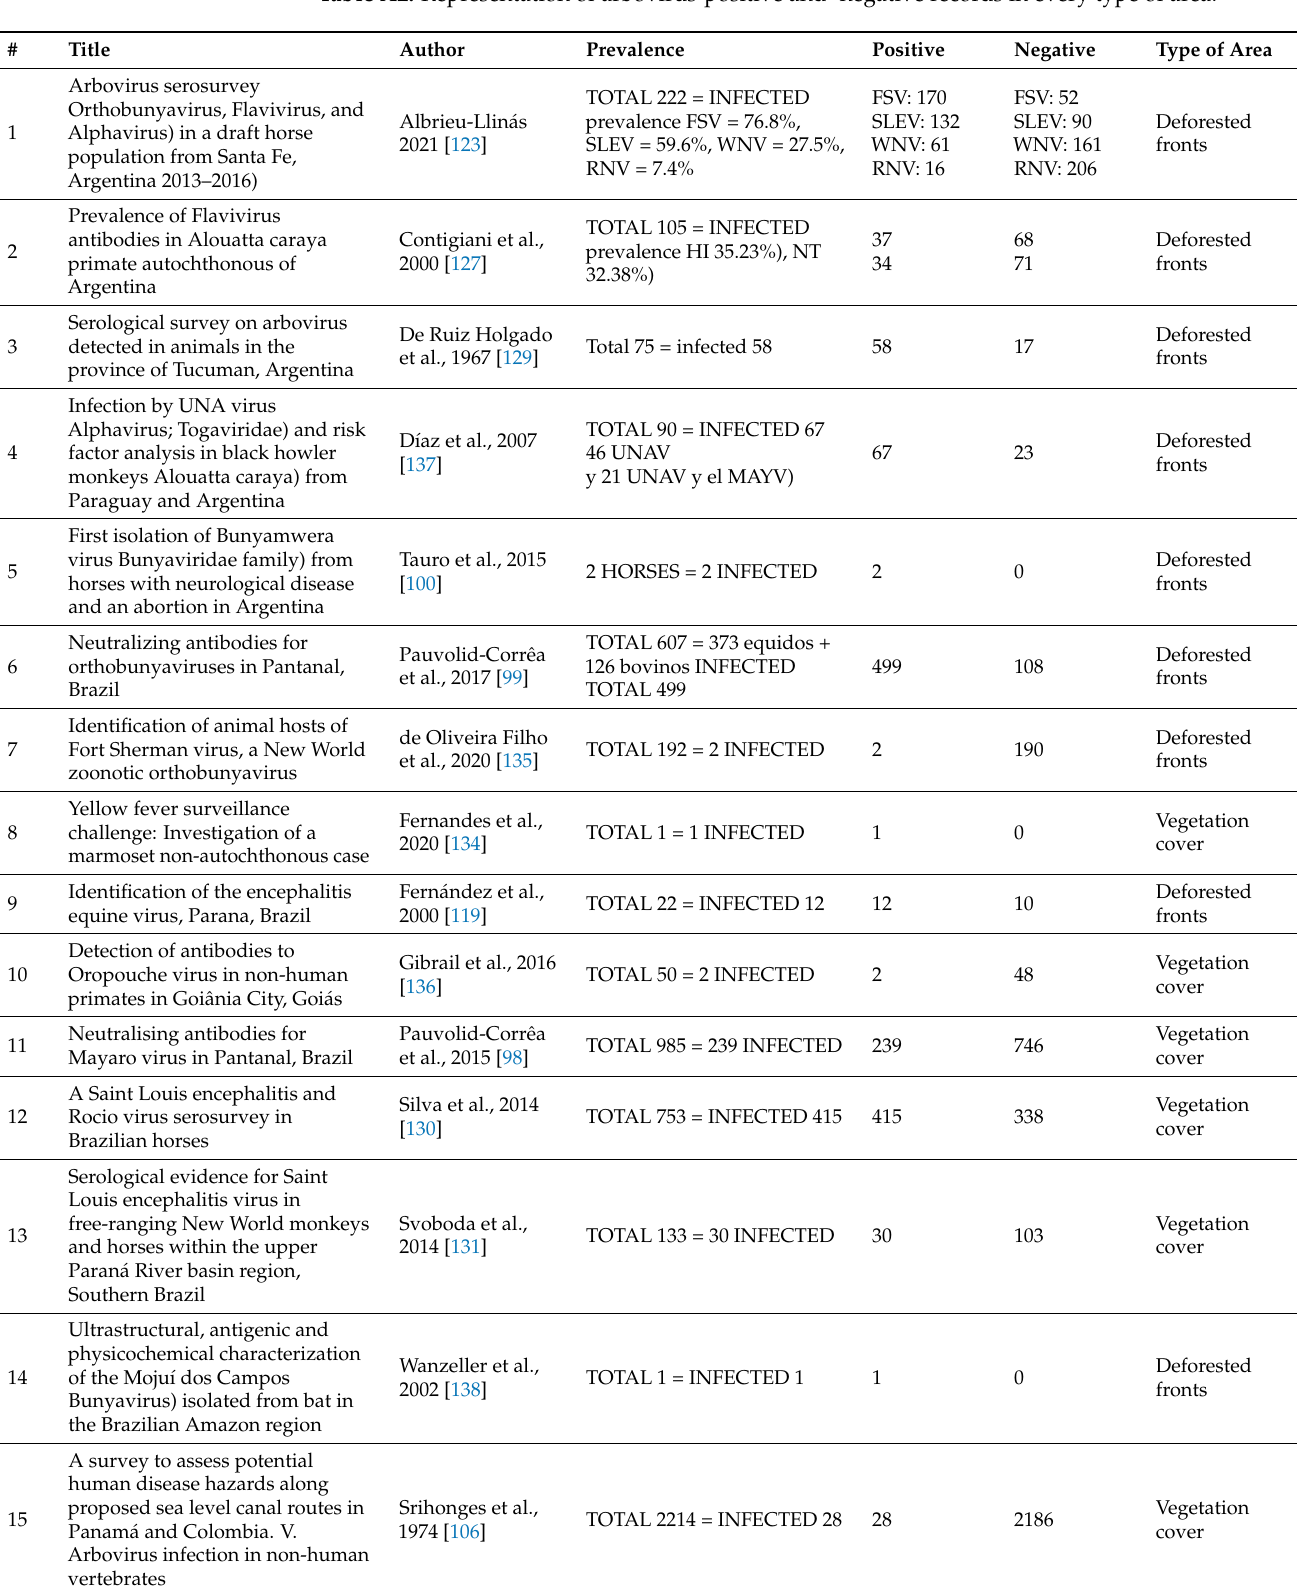
Table A2. Representation of arbovirus-positive and -negative records in every type of